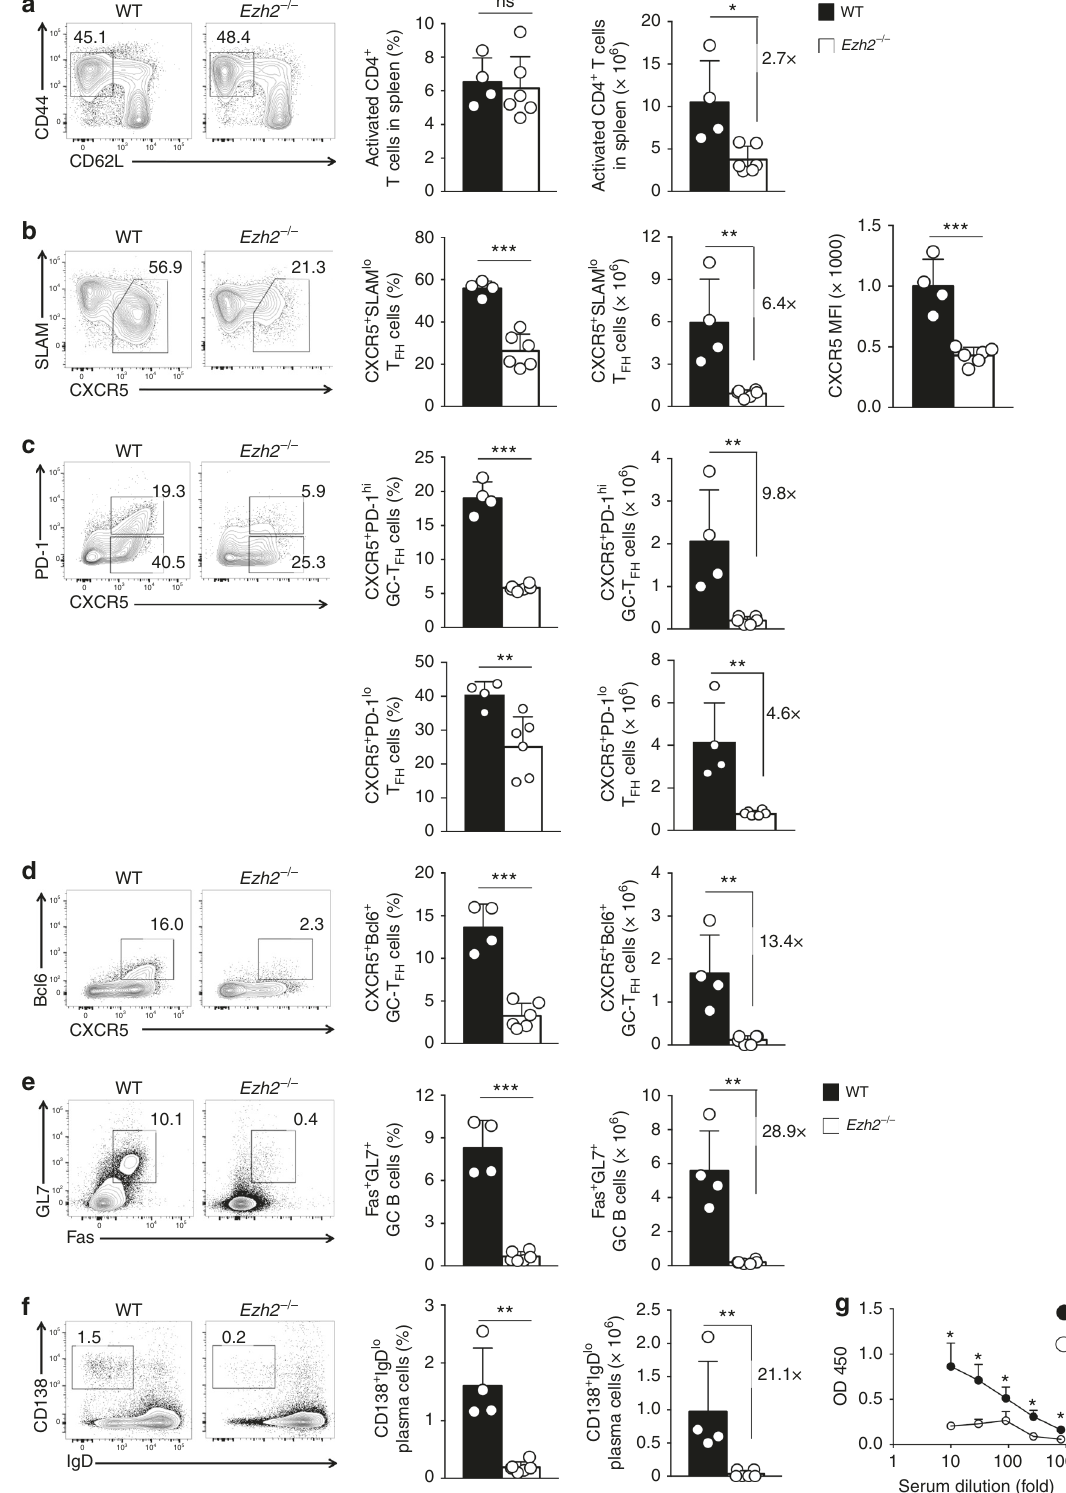
Fig. 1 Ezh2 is required for T FH and B cell responses to viral infection. a – f T cell-speci fi c ablation of Ezh2 affects T FH and B cell responses to viral infection. WT and Ezh2 – / – mice were infected with VacV. On 8 dpi , CD44 hi CD62L – activated CD4 + T cells were detected in the spleen ( a ), and further analyzed for CXCR5 + SLAM lo T FH cells and CXCR5 expression levels ( b ), CXCR5 + PD-1 lo T FH and CXCR5 + PD-1 hi GC-T FH cells ( c ), and CXCR5 + Bcl6 + T FH cells ( d ). Splenic B220 + CD19 + cells were analyzed for Fas + GL7 + GC B cells ( e ) and CD138 + IgD lo plasma cells ( f ). Contour plots are representative of two experiments, and cumulative data on frequency and numbers of each subset are the means±s.d., and each dot represents a mouse. ( g ) Detection of VacV-speci fi c IgG in sera of infected mice collected on 8 dpi ( n = 4 for WT and 5 for Ezh2 – / – ). * p <0.05; ** p <0.01; *** p <0.001 by unpaired two-tailed Student ’ s t